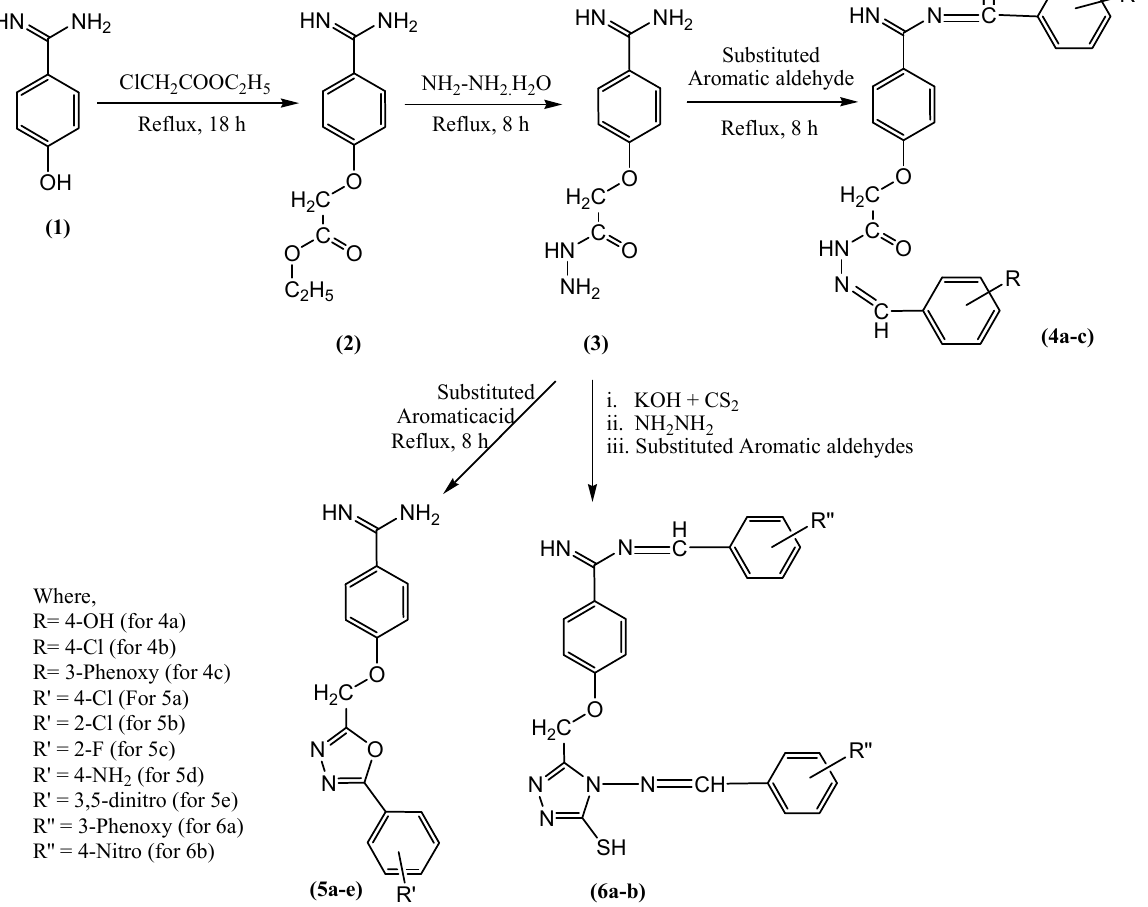
Figure 1. Scheme for synthesis of novel benzamidine analogues.